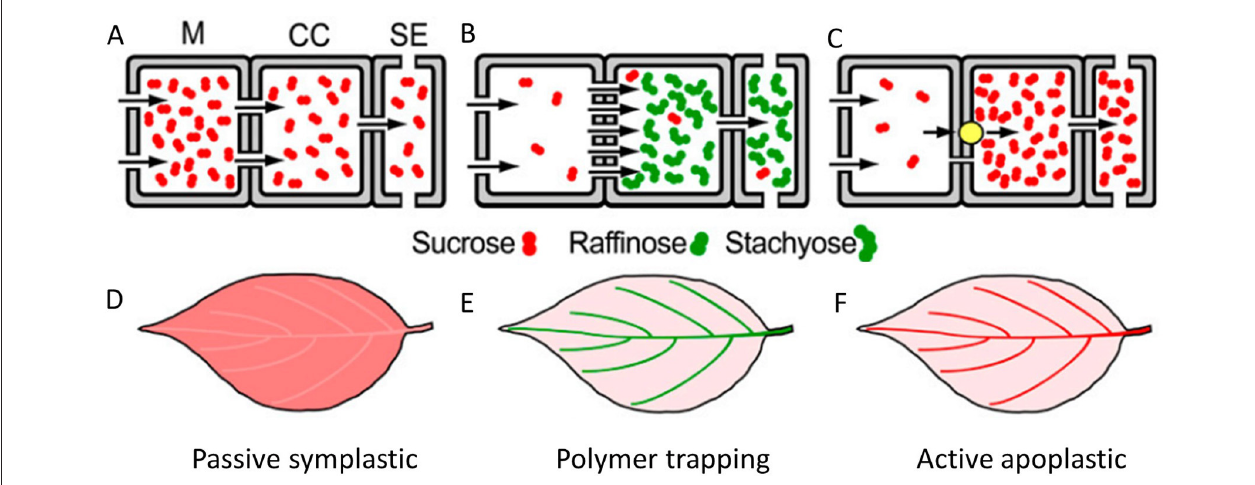
FIGURE 1 | Plants use passive or active strategies to load sugars into the phloem. (A) In passive loading sucrose diffuses through many present plasmodesmata according to a gradient in concentration, which is higher in the mesophyll (M), and smaller in the companion cells (CC), and sieve elements (SE). (B) Polymer trapping is an active loading strategy in which sucrose from the mesophyll enters the companion cells through plasmodesmata and is converted into a polymer such as raffinose and stachyose at the expense of energy. These molecules are too large to pass through plasmodesmata back into the mesophyll but fit the plasmodesmata connecting the companion cell to the sieve element and are loaded into the sieve element according to a concentration gradient. (C) In active apoplastic loading, almost no plasmodesmata connect mesophyll to companion cells, which requires an apoplastic route to load the companion cells. Loading occurs with a sucrose/H + co-transporter (yellow bullet), which consumes ATP and thus costs energy. (D) Passive loading follows a concentration gradient from higher sugar concentration in the mesophyll to lower concentration in the major veins (indicated by lighter color). (E,F) Active loading occurs against a concentration gradient, which is visualized by higher concentrations in major veins (indicated by brighter colors) compared to mesophyll. This material is adapted from Turgeon (2010) with the permission of the copyright holder Copyright Clearance